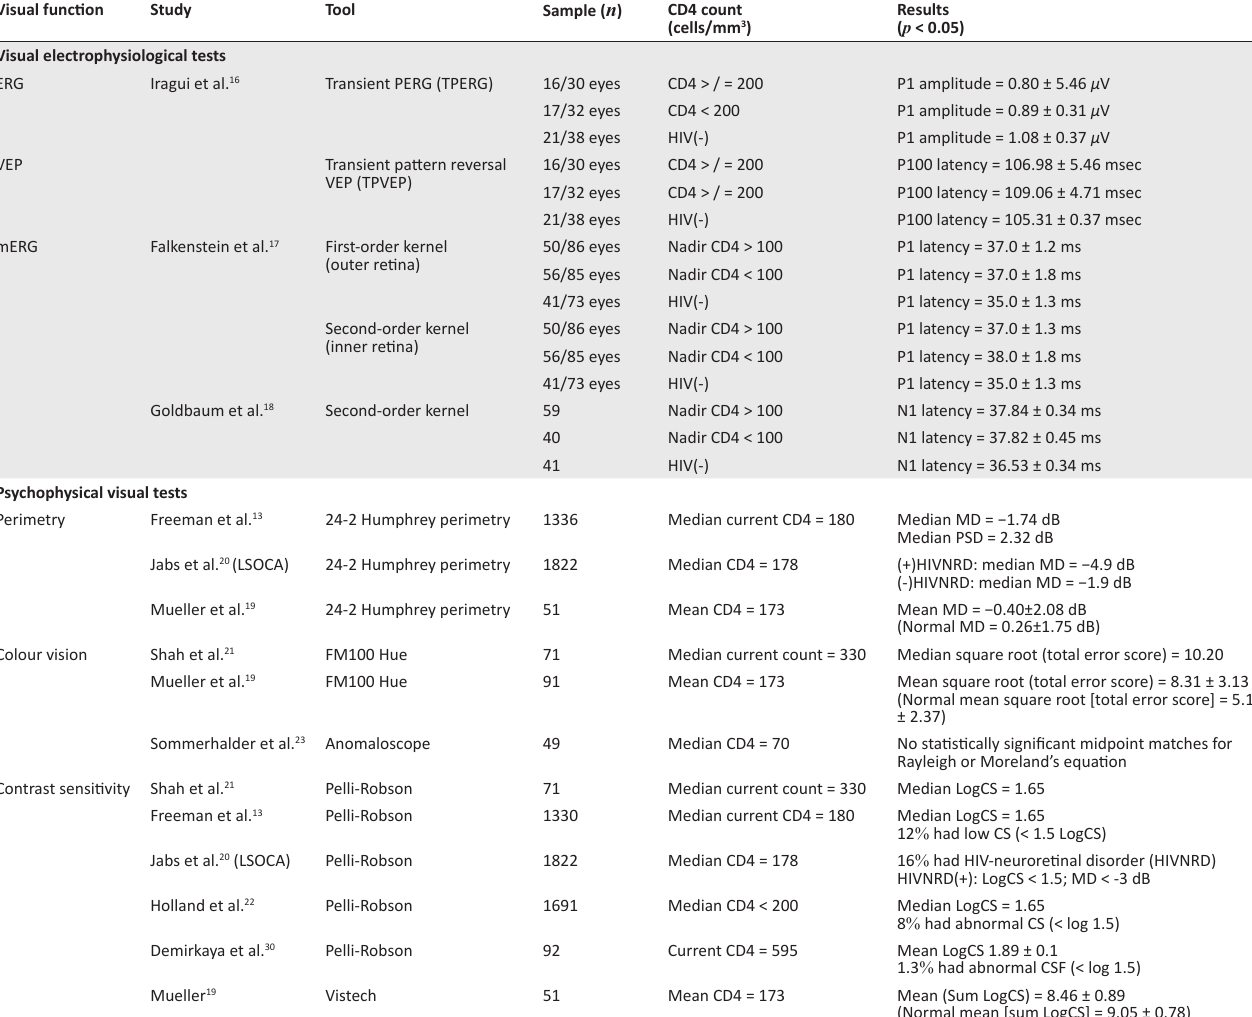
Results (cells/mm 3 ) ( p < 0.05)